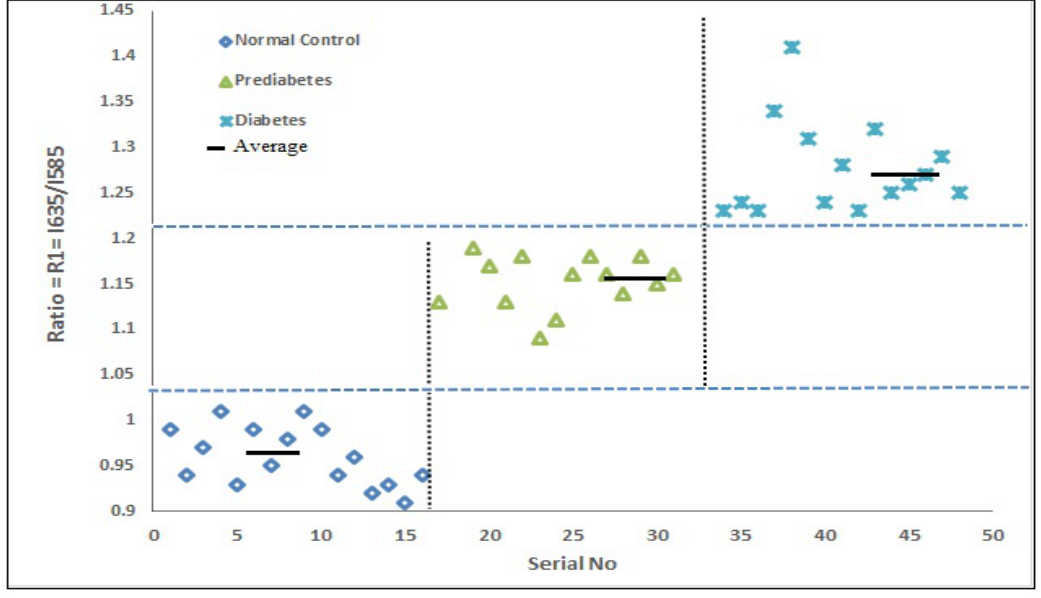
Figure 5. Scatter plot of R 1 = I 635 /I 585 values of the above three subjects; R1 is a measure of oxygen carrying capacity of red blood cells (RBCs).